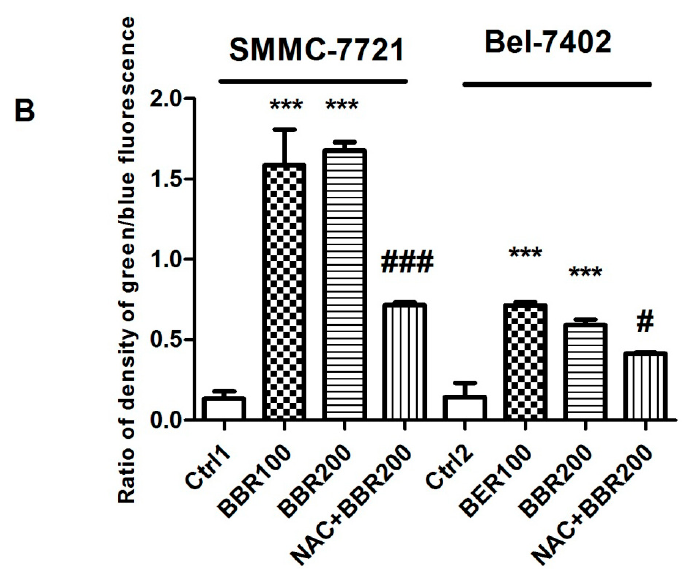
Figure 2. Increased reactive oxygen species (ROS) level in the high concentration of BBR-treated HCC cells by fluorescent microscopy. SMMC-7721 and Bel-7402 cells were incubated in 6-well plates and treated with BBR (100 and 200 μ M) for 6 h. 2,7-dichlorodihydrofluorescein diacetate (DCFDA) and Hoechst33258 were used for detecting intracellular ROS level by fluorescent microscopy. Pretreatment of 5 mM of N -Acetyl- L -cysteine (NAC) was added as a negative control. ( A ) ROS level was observed by fluorescent microscopy. D: DCFDA (green fluorescence); H: Hoechst33258 (blue fluorescence); M: merge; ( B ) ROS level was calculated by ImageJ 1.38x software (NIH, USA). *** p < 0.001 ( vs. the control group); # p < 0.05 ( vs. BBR200 group); ### p < 0.001 ( vs. BBR200 group).